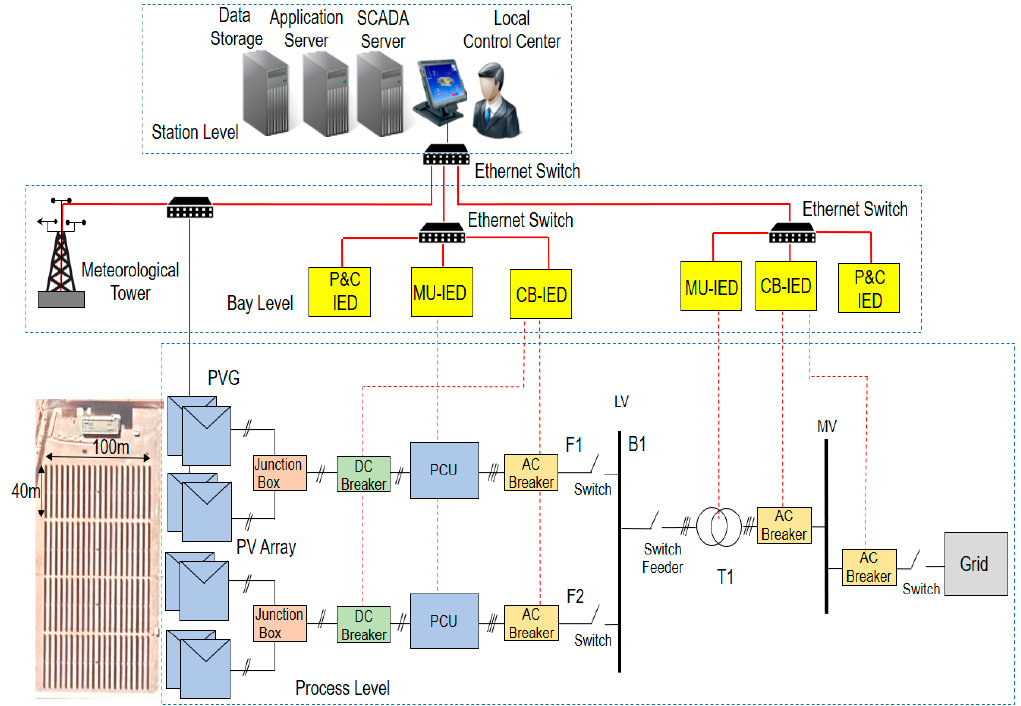
Figure 5. Proposed communication network model for the PV power plant. PVG: PV generator; PCU: power conditioning unit F: feeder; B: bus; T: transformer, LV: low voltage; MV: medium